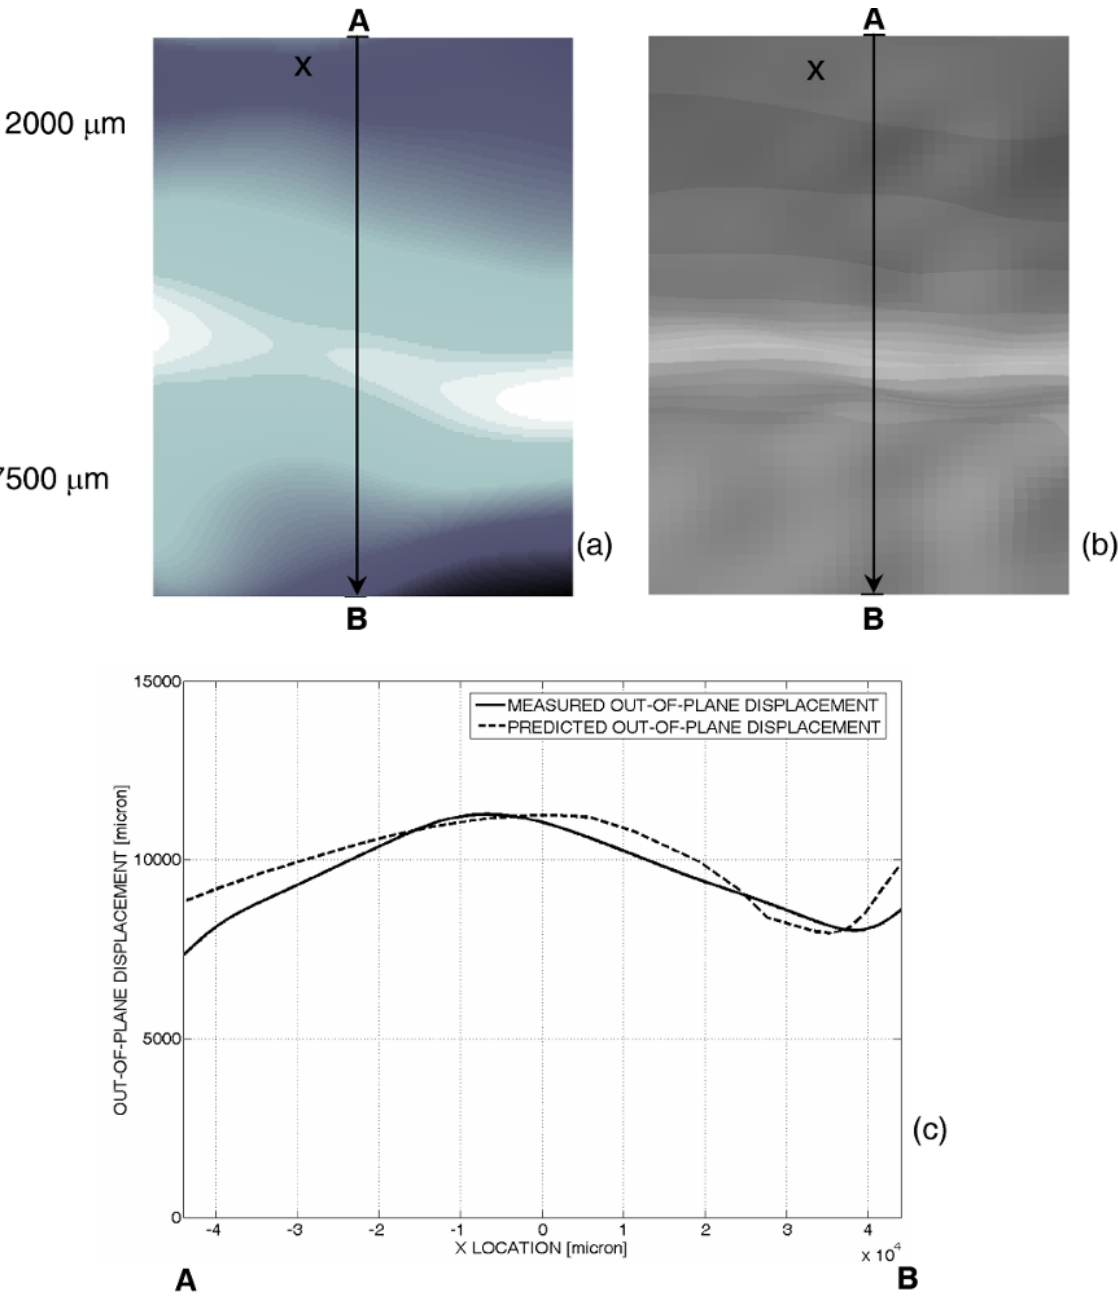
Figure 7. Comparison of out-of-plane displacement maps ( a ) measured with projection moiré; or ( b ) computed by ABAQUS for the 10 mm end-shortening given to the panel; and ( c ) displacement distributions compared along the AB control